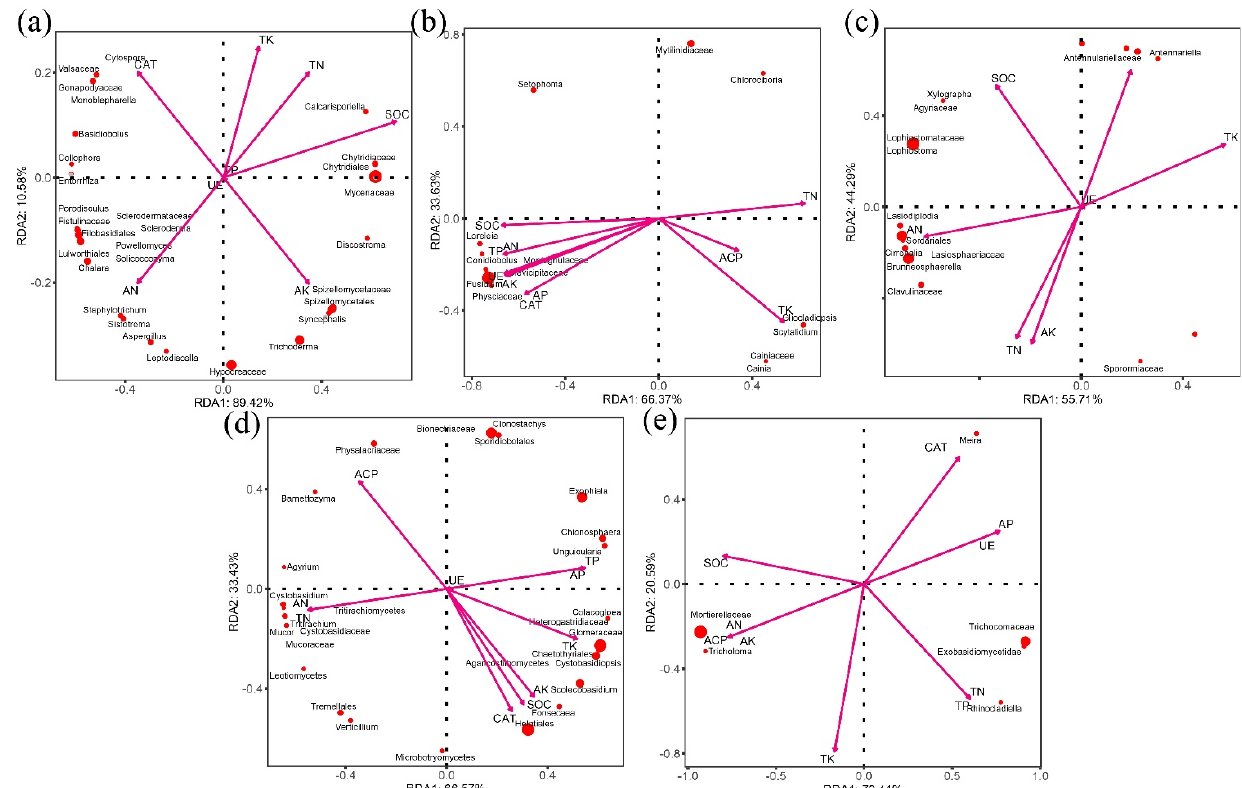
Figure 9. Redundancy analysis (RDA) of topsoil fungal communities under different litter mulching treatments and environmental characteristics. Arrows indicate environmental characteristics. The values of axes 1 and 2 are the percentages explained by the corresponding axis. ( a ) control, ( b ) leaf, ( c ) branch, ( d ) pericarp, ( e ) seed.